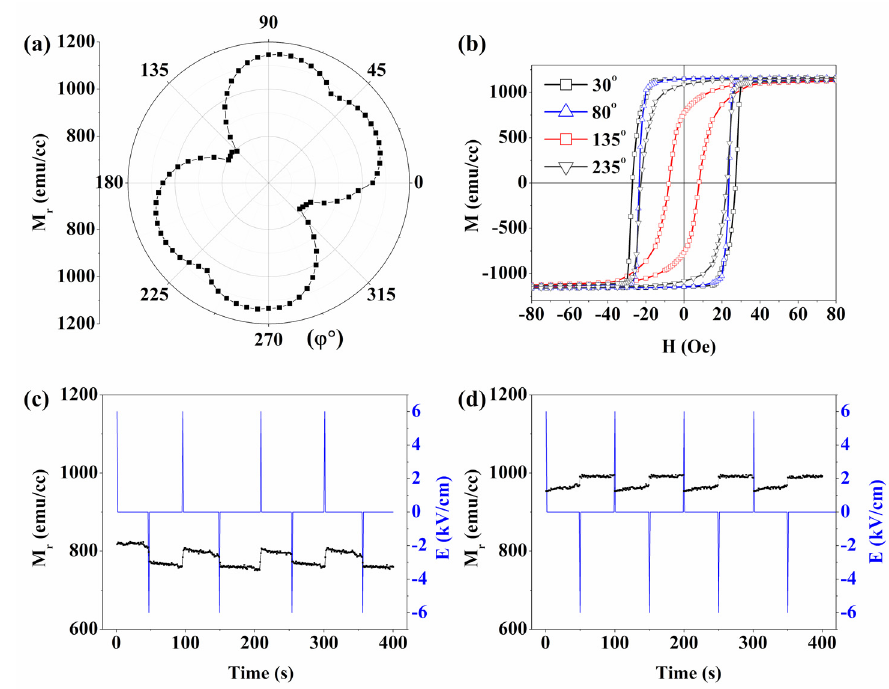
Figure 3. Angular dependence of the remanent magnetization (ARM) curve ( a ) and the magnetic hysteresis ( M–H ) loops ( b ) of FeSi/(011) PMN-0.32PT heterostructures. Non-volatile variation of M r at φ = 0° ( c ) and φ = 90° ( d ) under electric fields pulses of ±6 kV/cm.